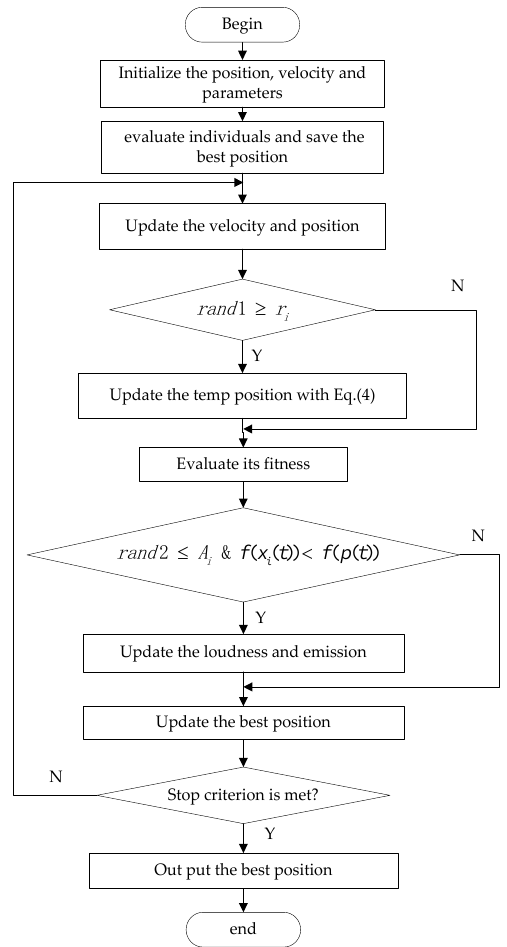
Figure 1. The flowchart of the standard bat algorithm (BA).